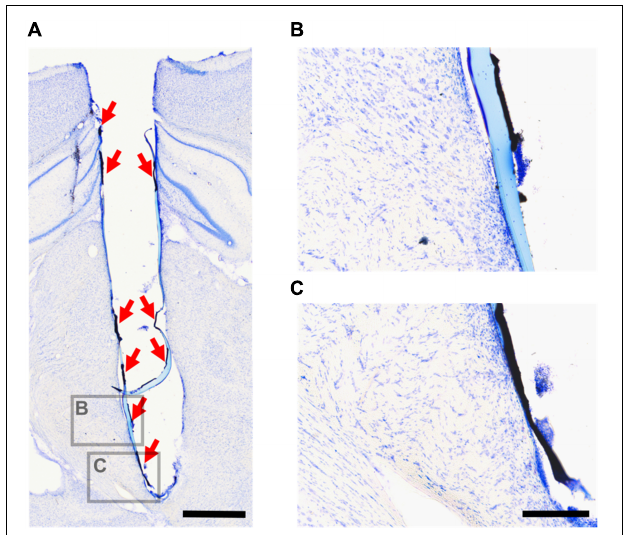
FIGURE 11 | Delaminated CH coating in the rat brain. After tissue fixation and electrode array removal, the brains were sectioned and stained with cresyl violet. This is an example of delaminated CH coating remaining in the brain after electrode array removal ( A , red arrows). Higher magnification images (B,C) show that the CH coating delaminated in large pieces. Scale bar (A) = 1 mm (applies to A ), scale bar (B) = 200 µ m (applies to B,C